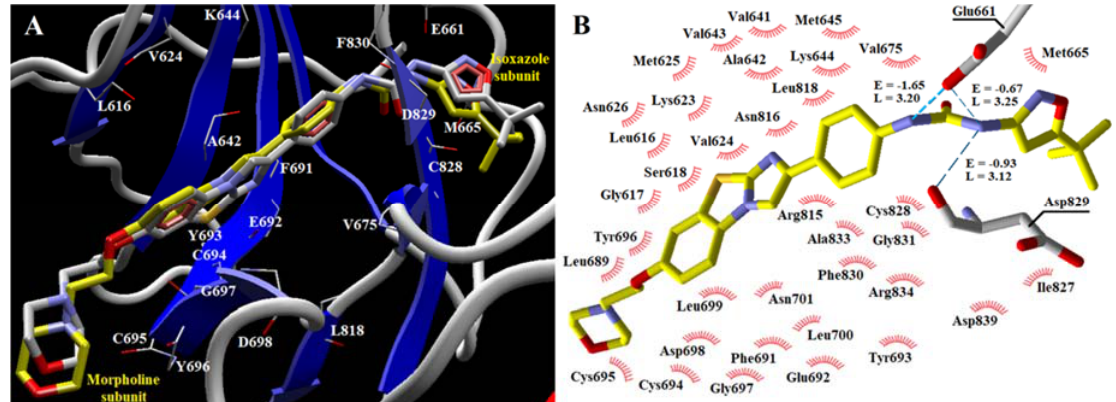
Figure 2. Quizartinib into the Feline McDonough Sarcoma (FMS) ‐ like tyrosine kinase 3 (FLT3) interaction site. ( A ) The structure with yellow carbon atoms is the redocked Quizartinib. ( B ) Hydrogen bonds provide evidence for redocked Quizartinib and amino acid residues are located at a distance of 5Å.